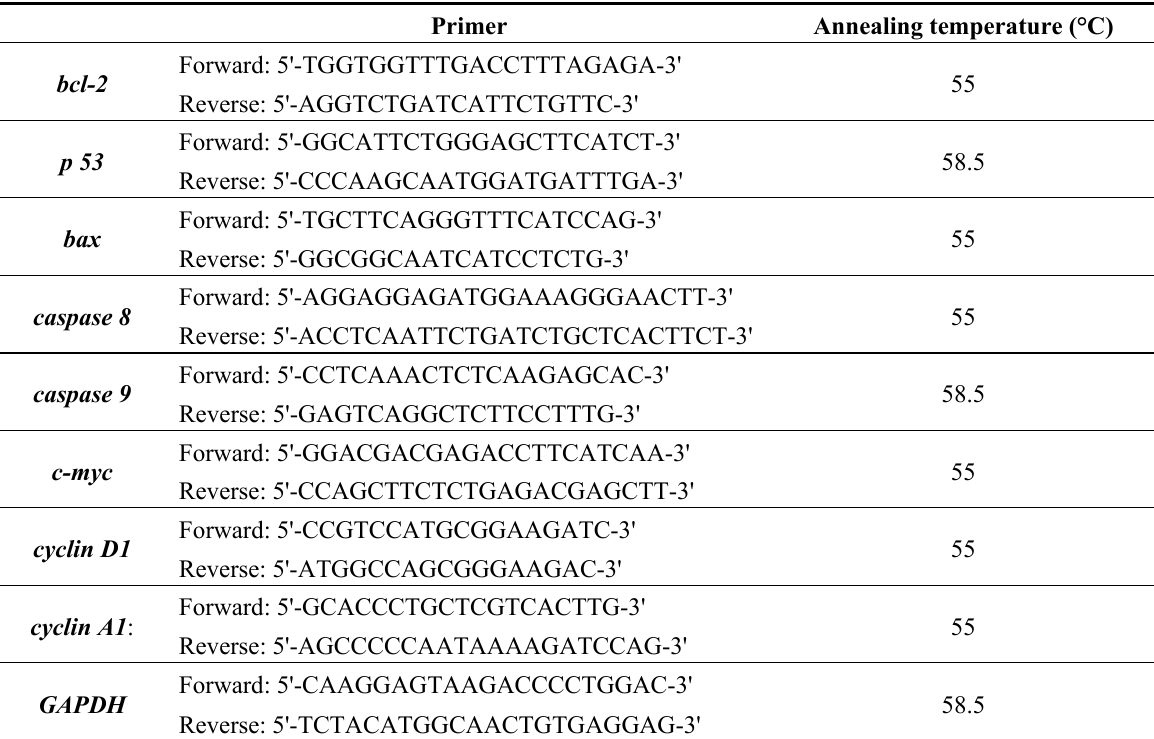
Table 3. Primers used for